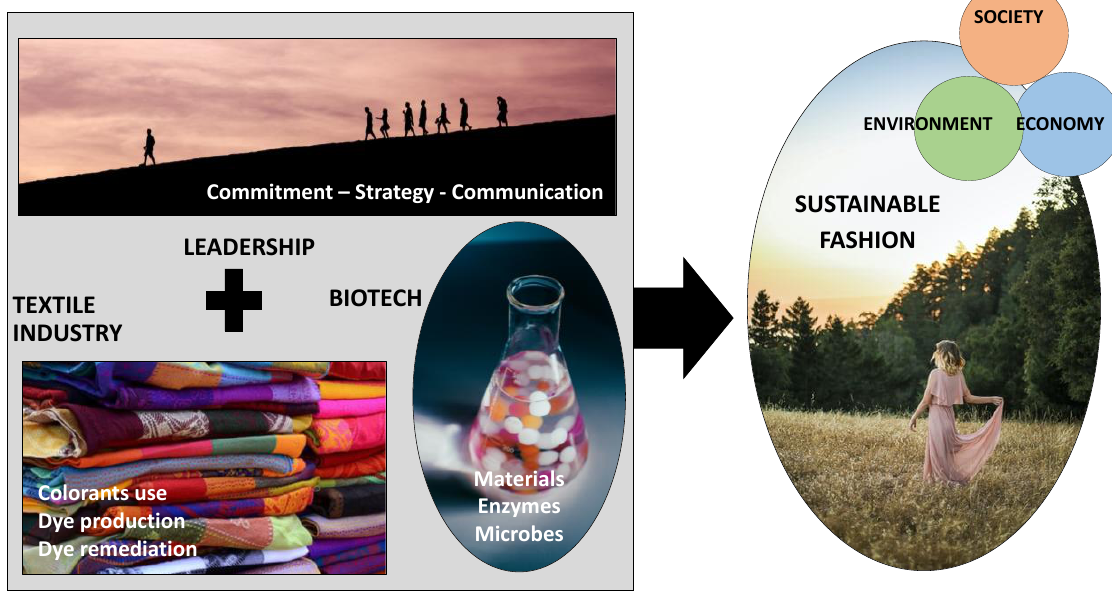
Figure 1. The journey towards a sustainable future requires the combination of multiple aspects, with biotechnology and leadership playing an equally key role in the implementation of change to the textile industry and its environmentally hazardous use of synthetic colorants.